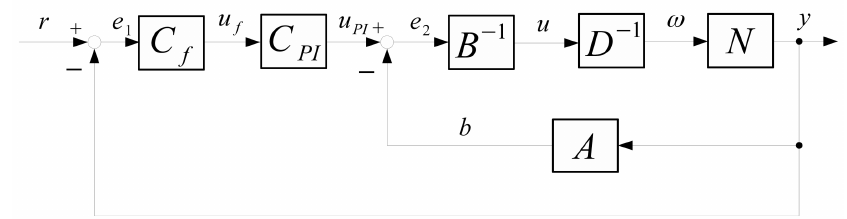
Figure 6. The adaptive control